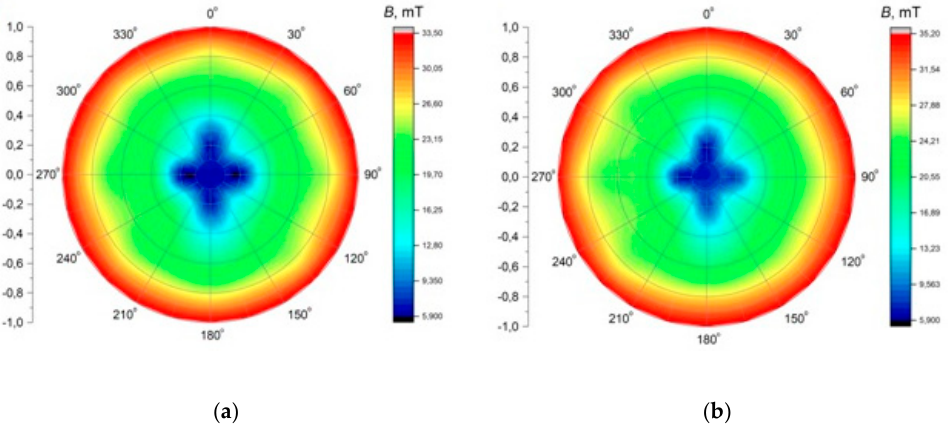
Figure 11. The contour patterns of the spatial distribution of the magnetic field in the selected cross-section of the RMF generator (in the middle of set-up) for f = 30 Hz ( a ) and f =50 Hz ( b ).